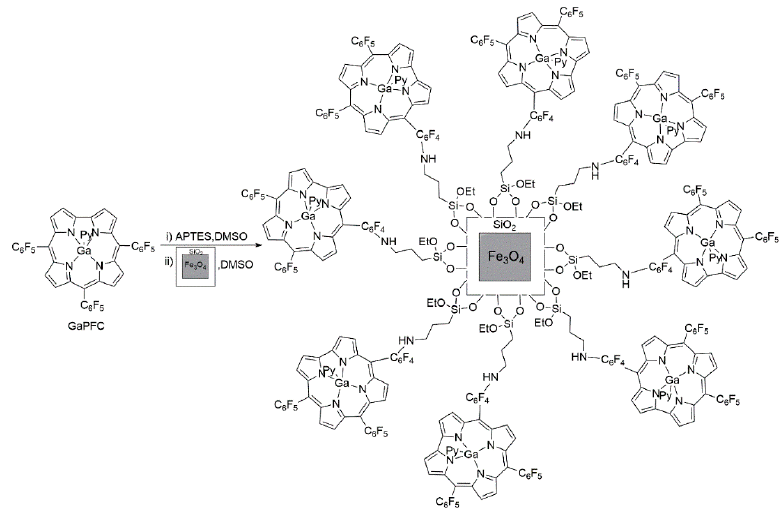
Figure 1. Synthetic routes to magnetite–corrole hybrid nanoparticles.